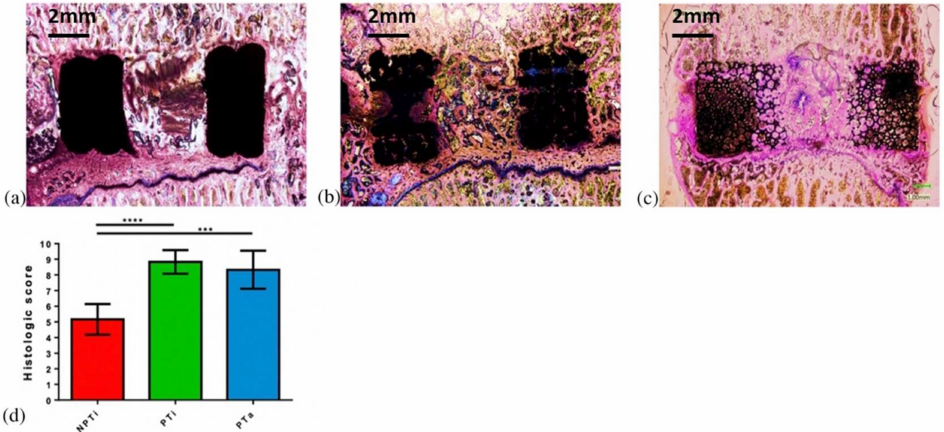
Figure 10. In vivo bone morphology stained with Sanderson’s rapid bone stain (Dorn & Hart Microedge, Loxley, AL) and counterstained with acid fuchsin. ( a ) Nonporous titanium cage (NPTi), ( b ) 60% porous titanium cage (PTi), and ( c ) porous tantalum cage (PTa); ( d ) modified bone healing scores for NPTi, PTi, and PTa. n = 6, *** p < 0.001, **** p <